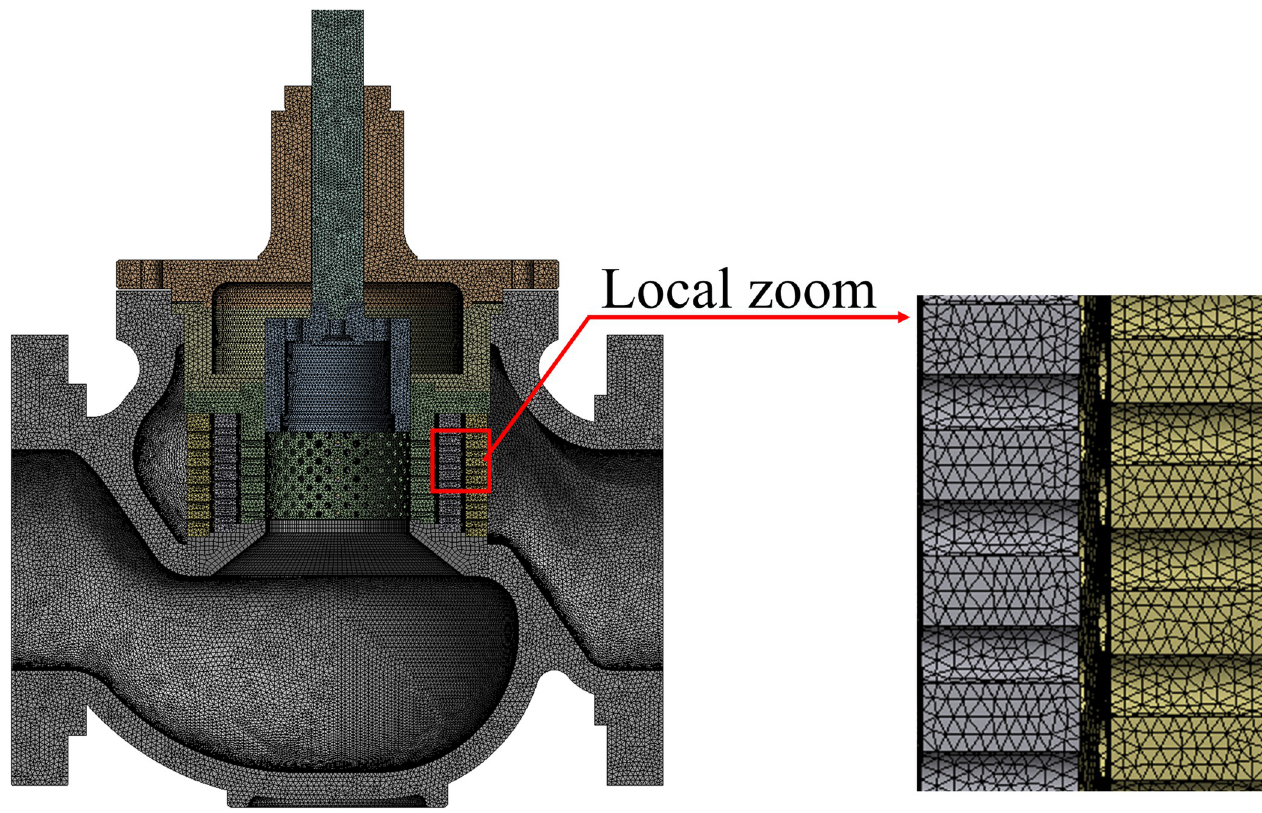
Fig 10. Solid finite element mesh of the valve at a 100% opening.